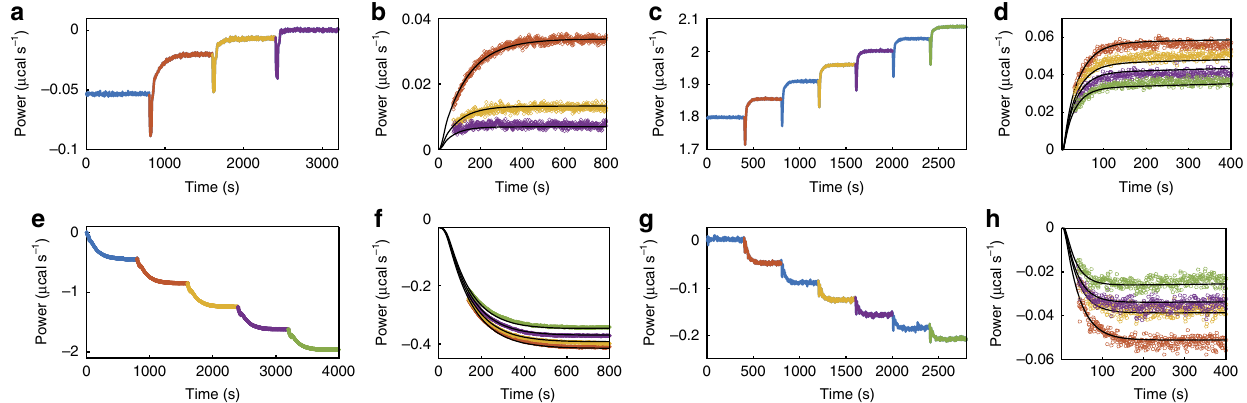
Fig. 2 Kinetics of inhibition and initiation experiments. a Kinetics of inhibition experiment with compound 1 using a Malvern ITC-200 calorimeter. Compound 1 is titrated into cell containing POP and TRH. b Overlay of injections 2, 3, and 4 (orange, yellow, and purple circles) with fi t (black line). c Kinetics of inhibition experiment with compound 4 using a Malvern ITC-200 calorimeter. Compound 4 is titrated into cell containing POP and TRH. d Overlay of injections 2, 4, 5, and 7 (orange, yellow, purple, and green circles) with fi t (black line). e Kinetics of initiation experiment of compound 1 with a Malvern VP-ITC calorimeter. Compound 1 and POP are titrated in the cell containing TRH. f Overlay of injections 2, 3, 4, and 5 (orange, yellow, purpl,e and green circles) with fi t (black lines). g Kinetics of initiation experiment with compound 4 using a Malvern ITC-200 calorimeter. Compound 4 and POP are titrated into cell containing TRH. h Overlay of injections 2, 4, 5, and 7 (orange, yellow, purple, and green circles) from c with fi t (black lines)